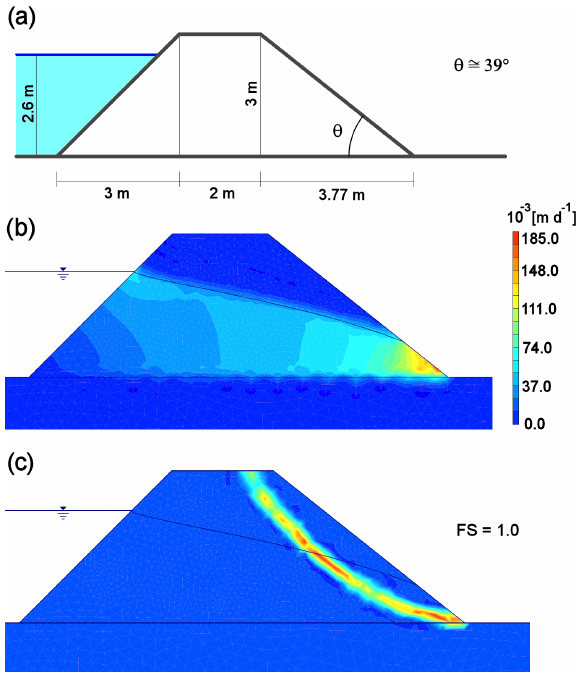
Figure 8. (a) Cross-sectional sketch of an instable dam with the main elements dimension, (b) water velocity field moving in the dam body and associated phreatic surface, and (c) breaking surface generated by a unitary factor of